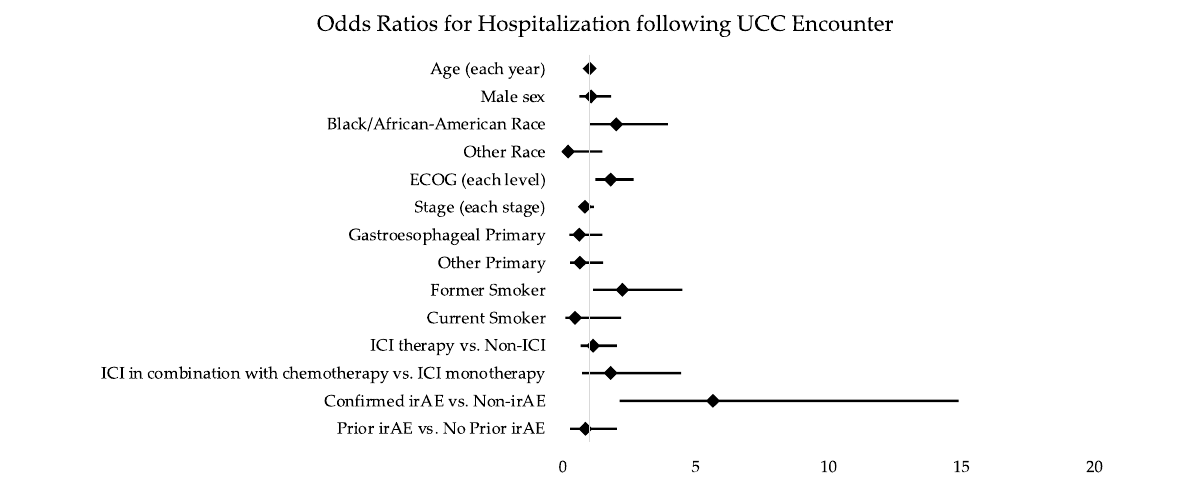
Figure 3. Odds ratios for clinical features and hospitalization following UCC encounters.